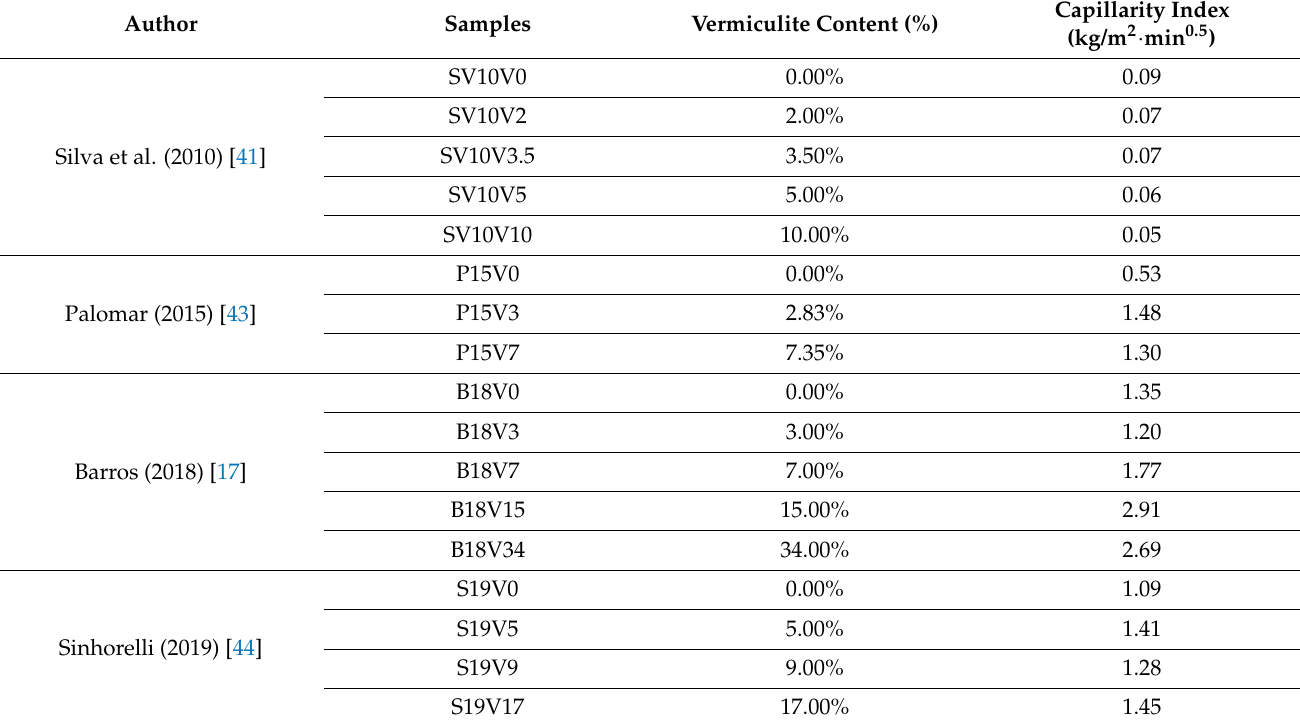
Table 9. Values of capillarity index and vermiculite content from the reviewed articles